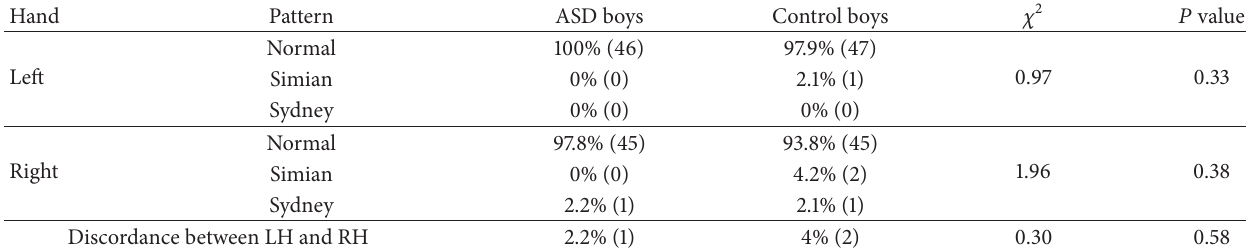
Table 2: Palmar flexion creases (PFCs) as a percentage of all palms for boys with ASD and typically developing boys. Hand Pattern